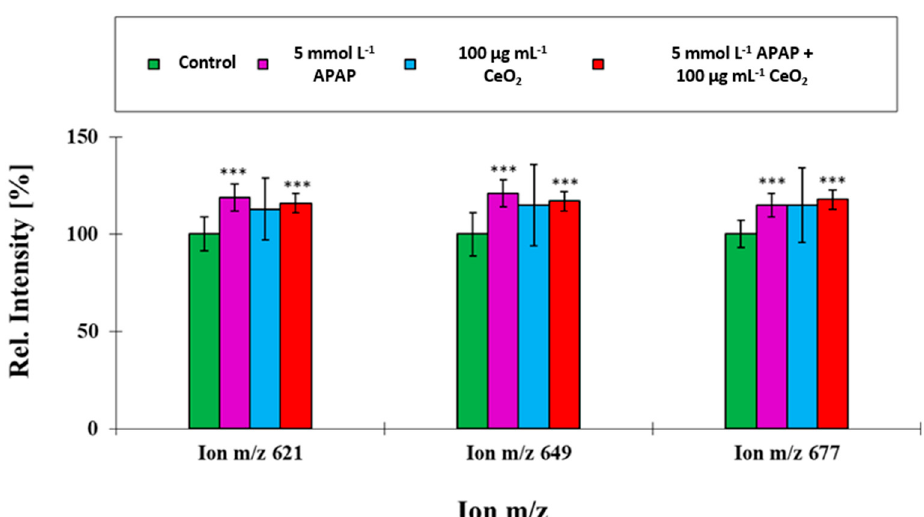
Figure 7. Metabolic changes of cell membrane lipid patterns of HuH-7 cells after treatment with APAP (5 mmol L − 1 ), CeO 2 NPs (100 µg/mL) and APAP (5 mmol L − 1 ) plus CeO 2 NPs (100 µg/mL), as identified by means of ToF-SIMS in combination with multivariate data analysis. The diagram shows the values of the discriminant scores obtained from Fisher’s discriminant analysis of 24 HuH- 7 samples. The model was evaluated using the “leave-one-out” formalism (100% correct grouping of ungrouped cases).